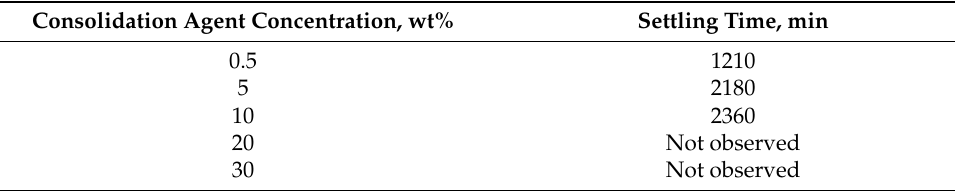
Table 5. Three-phase foam properties.